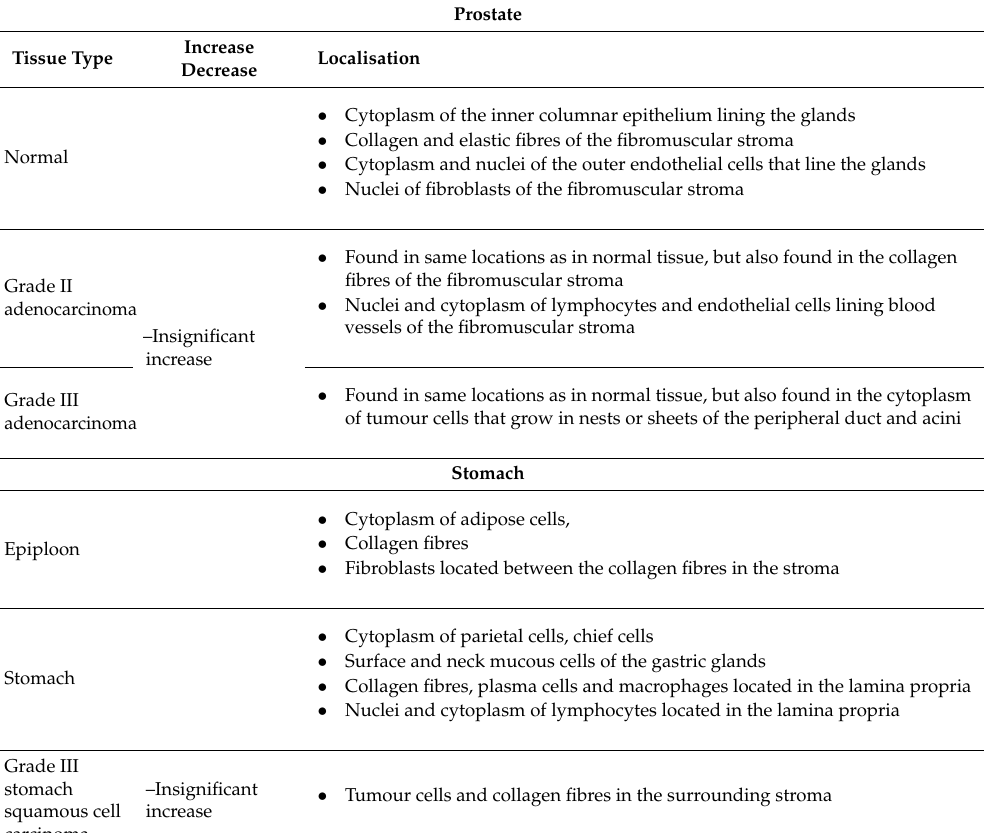
Table 1. Summary of localization and transcription data for Tspo in cancer from various